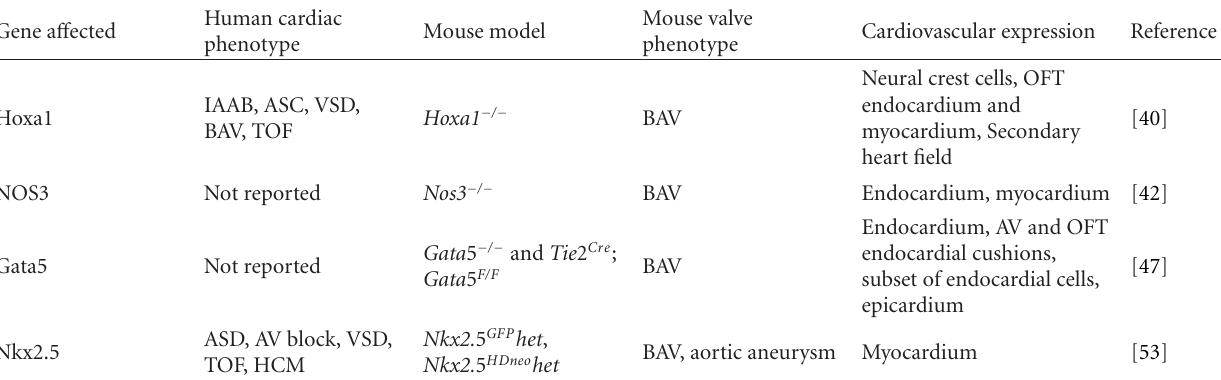
Table 2: Mouse models of bicuspid aortic valve